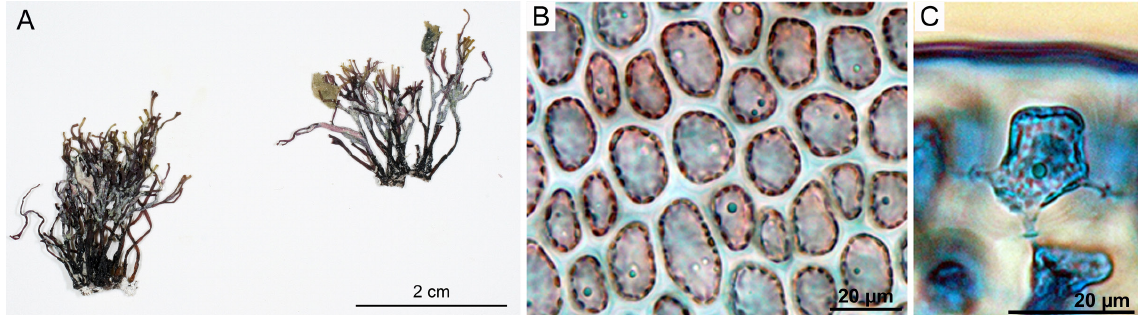
Fig. 4. Palisada crustiformans (McDermid). A . Voucher specimen of P. crustiformans (ARS03327 / BISH 766726 ) collected at Hawaii Island (type locality). B . Outer cortical cells in surface view. C . Detail of outermost cortical cell showing small spherical structure similar to ‘corps en cerise’ and secondary pit connections with adjacent